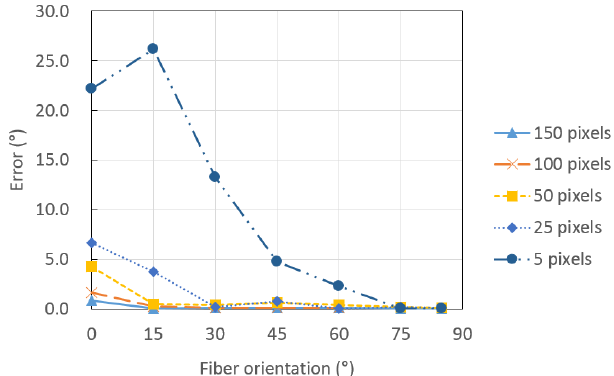
Figure 3. Error of the measured orientation of an artificial fiber image according to the number of pixels in the diameter. Table 2. Measured orientation of the artificial fiber image according to the number of pixels in the